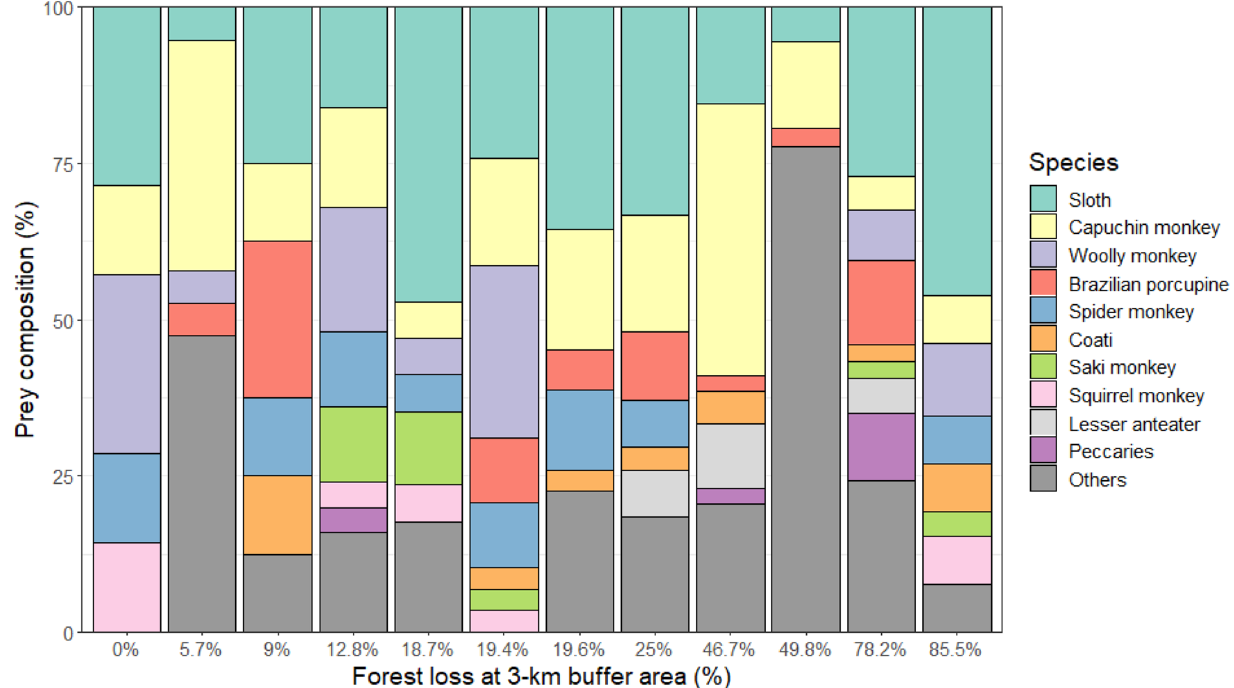
Figure 5. Species composition of prey items delivered to active harpy eagle nests. Main prey species are ordered in terms of overall abundance. Each column represents a nest, ordered by the landscape context from the lowest to the highest amount of forest loss within a 3-km buffer area around each nest site. The harpy eagle prey base consists of arboreal forest vertebrate species even when nests are situated in highly deforested landscapes.